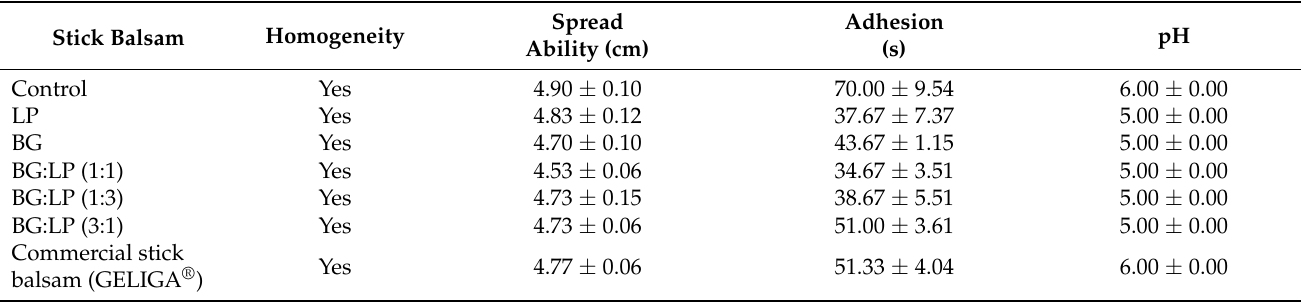
Table 2. Characterization of spice stick balsams.